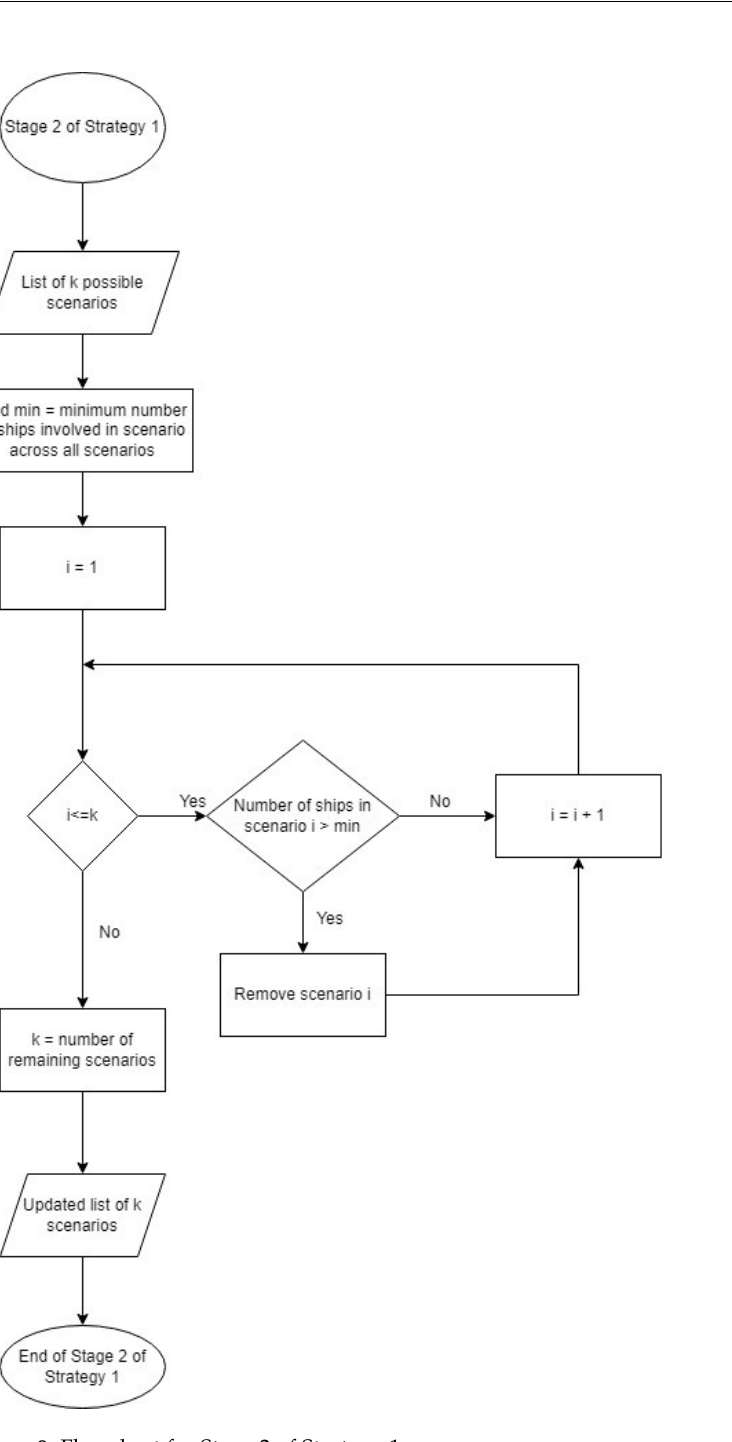
Figure 8. Flowchart for Stage 2 of Strategy 1.